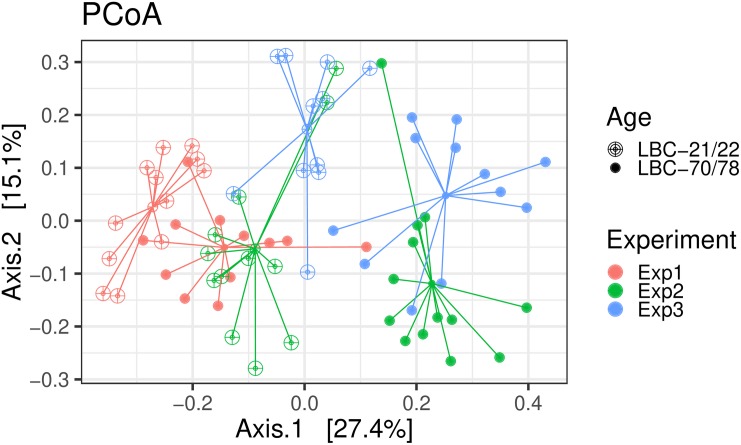
Bray-Curtis dissimilarity-based principal coordinate analysis (PCoA) was performed on caecal samples collected in experiments 1–3. Each point represents a different bird infected at different age [LBC-21/22, Lohmann Brown-Classic, infection at the age of 21/22 days (open points); LBC-70/78, Lohmann Brown-Classic, infection at the age of 70/78 days (filled points)]; coloured lines connect birds of one experiment (Exp 1, Experiment 1; Exp 2, Experiment 2; Exp3, Experiment 3).